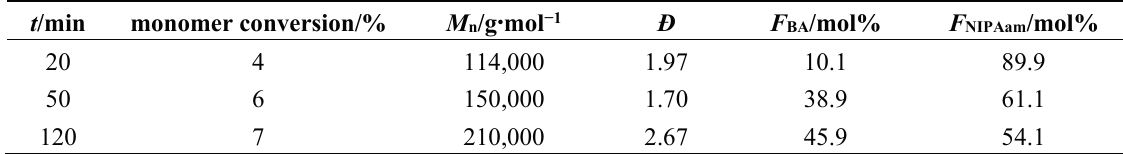
Table 1. Monomer conversion, molar mass data, and polymer composition of starpoly [(NIPAam- co - 1.1 )- block -BA] samples resulting from the block copolymerization of starpoly (NIPAam- co - 1.1 ) of M n = 70,000 g·mol − 1 with 700 mmol·L − 1 butyl